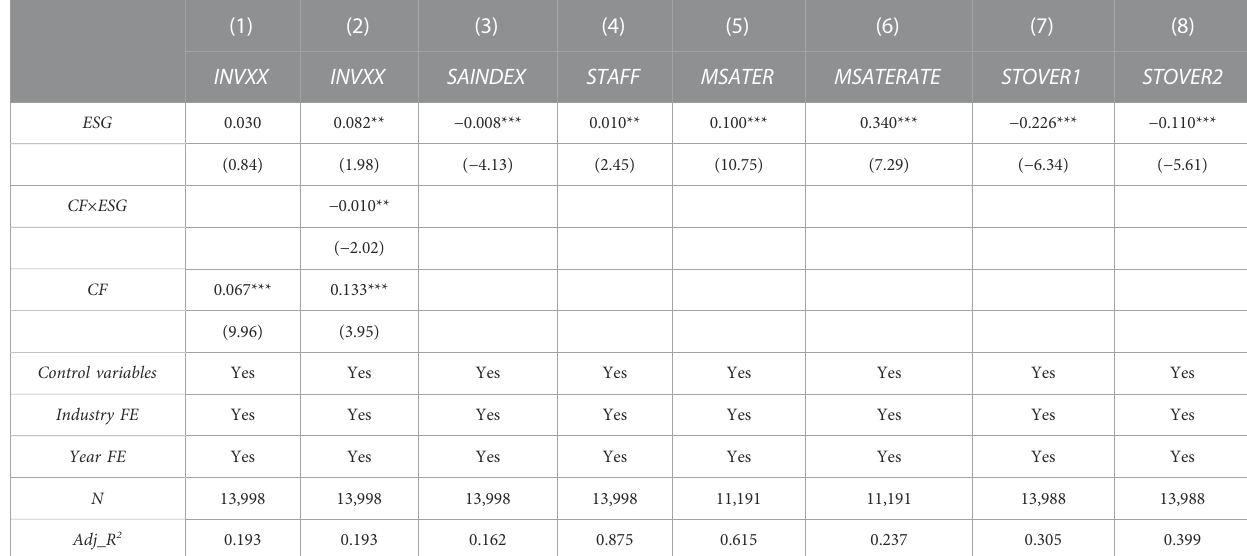
TABLE 7 Mechanism test